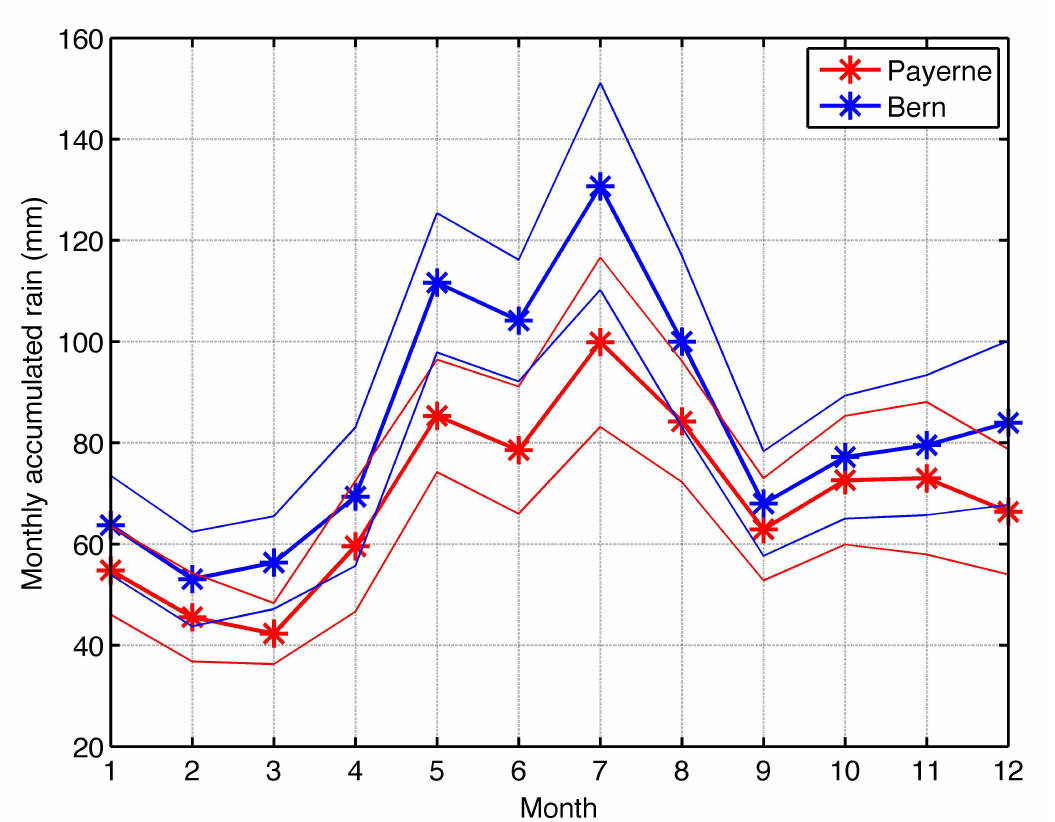
Figure 4. Climatology of monthly accumulated precipitation at Payerne ( red ) and Bern ( blue ) derived from rain gauge measurements (January 2007 to December 2016). The thick lines with the stars denote the arithmetic mean, and the thin lines denote the error of the mean.